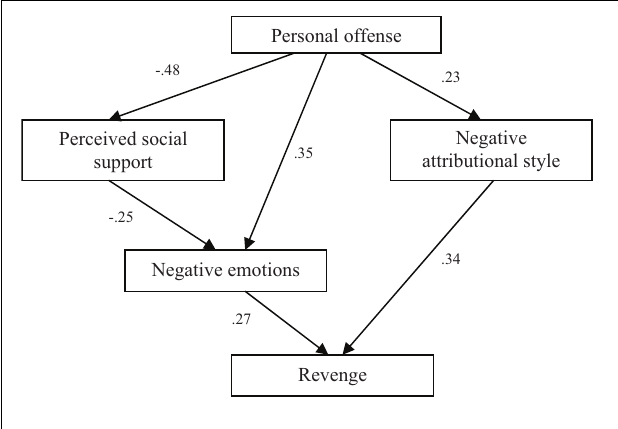
FIGURE 3 | Structural model for